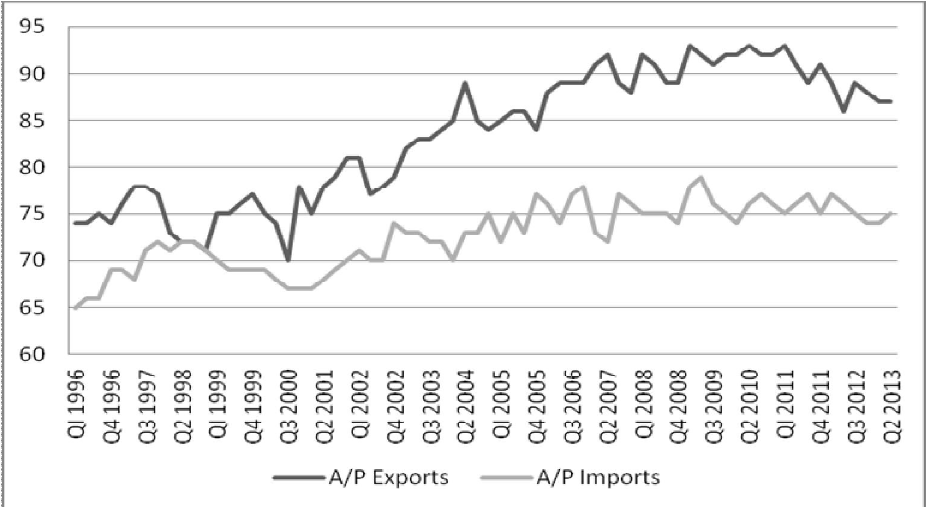
Graph 4: A/P Index for Egypt